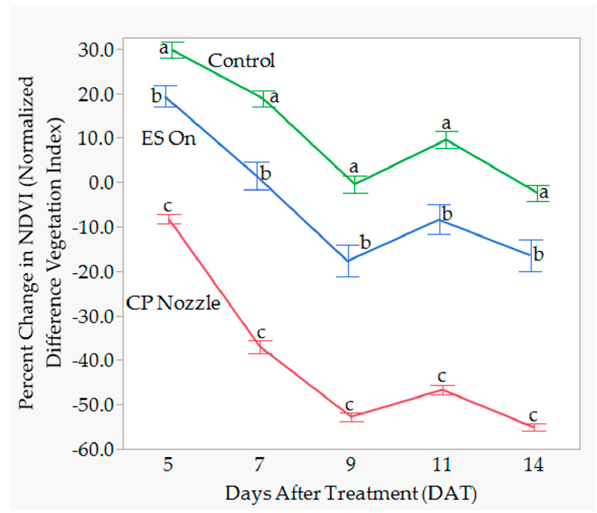
Figure 8. The percent change in NDVI at 5, 7, 9, 11, and 14 days after treatment (DAT). Means (±SEM) within each DAT followed by the same lowercase letter are not significantly different ( p < 0.05) according to Tukey’s HSD test. The treatments shown in the graph are the Control, the Electrostatic charged on (ES On), and the conventional CP nozzle.